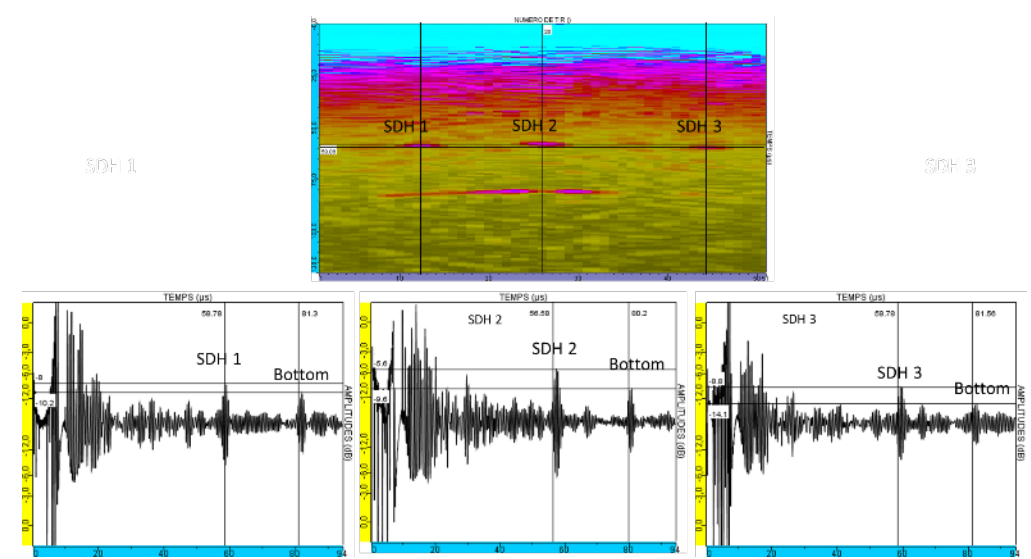
Figure 18. Experimental results. B-scans and A-scans of the 3 SDHs: A high pass filter was applied to eliminate low-frequency noise.